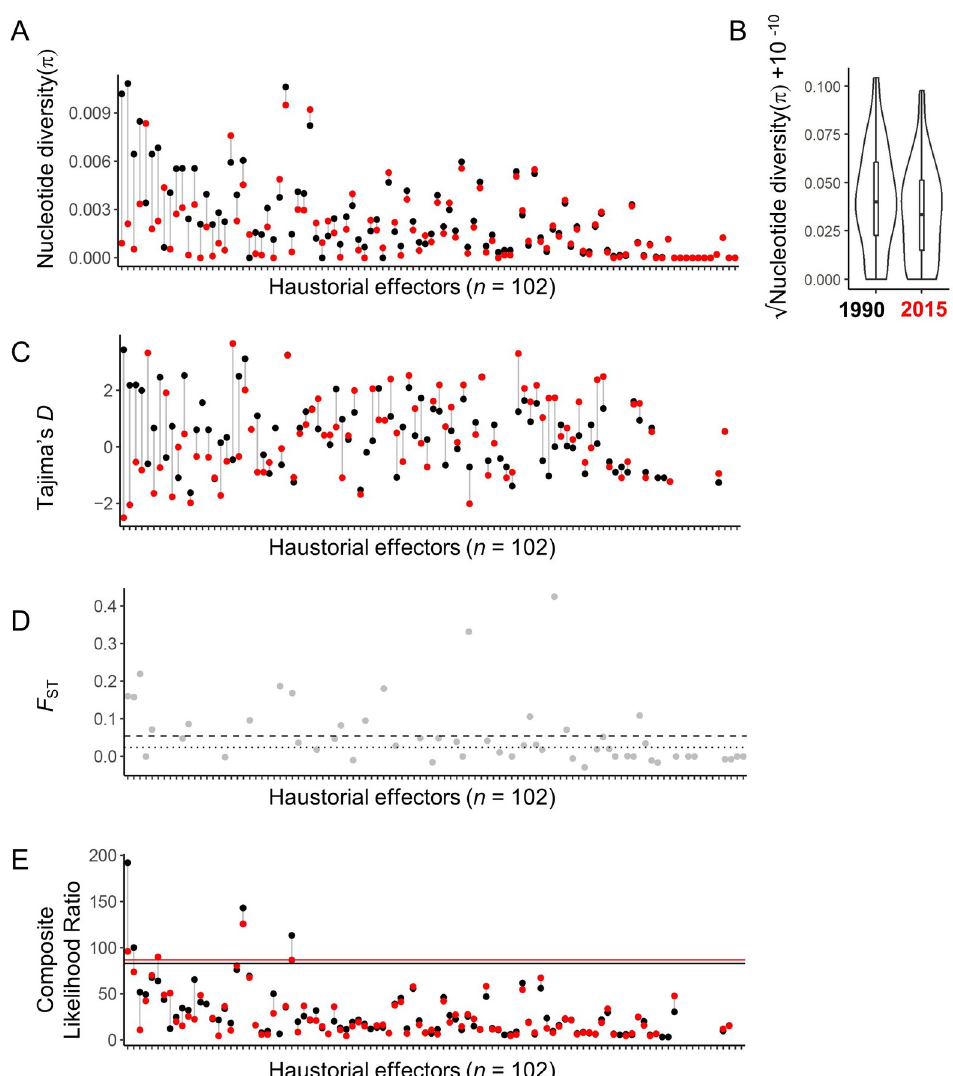
Fig 5. Evidence for selection in haustorially-expressed predicted effector repertoires. (A) Nucleotide diversity ( π ) values for predicted effectors in 12SD80 with haustorial expression ( n = 102, x-axis) using 1990 (black) and 2015 (red) datasets. (B) Distribution of nucleotide diversity values (y-axis) for predicted effectors in 12SD80 with haustorial expression in 1990 and 2015 (x-axis). A box plot was drawn inside each violin plot to indicate median and inter-quartile range values. (C) Tajima’s D values for predicted effectors in 12SD80. (D) F ST values for predicted effectors in 12SD80 when comparing 1990 and 2015 datasets. The mean for all genes (0.05) is shown by a dashed line at and whereas the dotted line represents the median value (0.024). (E) Composite likelihood ratio (CLR) scores for predicted effectors of 12SD80. The horizontal lines in E show the 95% percentile thresholds for 1990 (black) and 2015 (red). List of haustorial effectors and raw data is provided in table